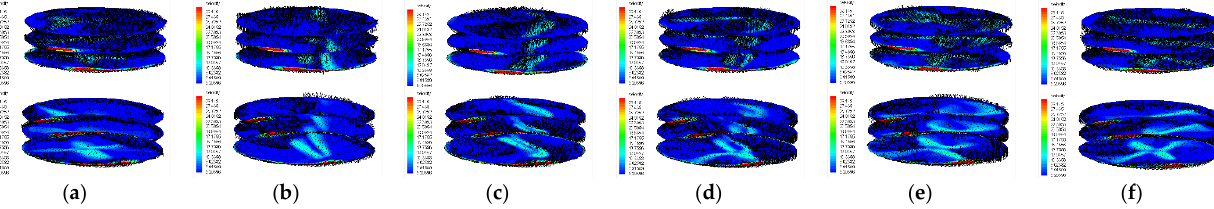
Figure 29. When inlet pressure = 15 MPa, gap = 1.5 mm, the variation of velocity of suction cup- θ 20 with time in adhesion interface plane at: ( a ) 5 ms, ( b ) 9.4 ms, ( c ) 13.8 ms, ( d ) 18.2 ms, ( e ) 22.6 ms, and ( f ) 27 ms.